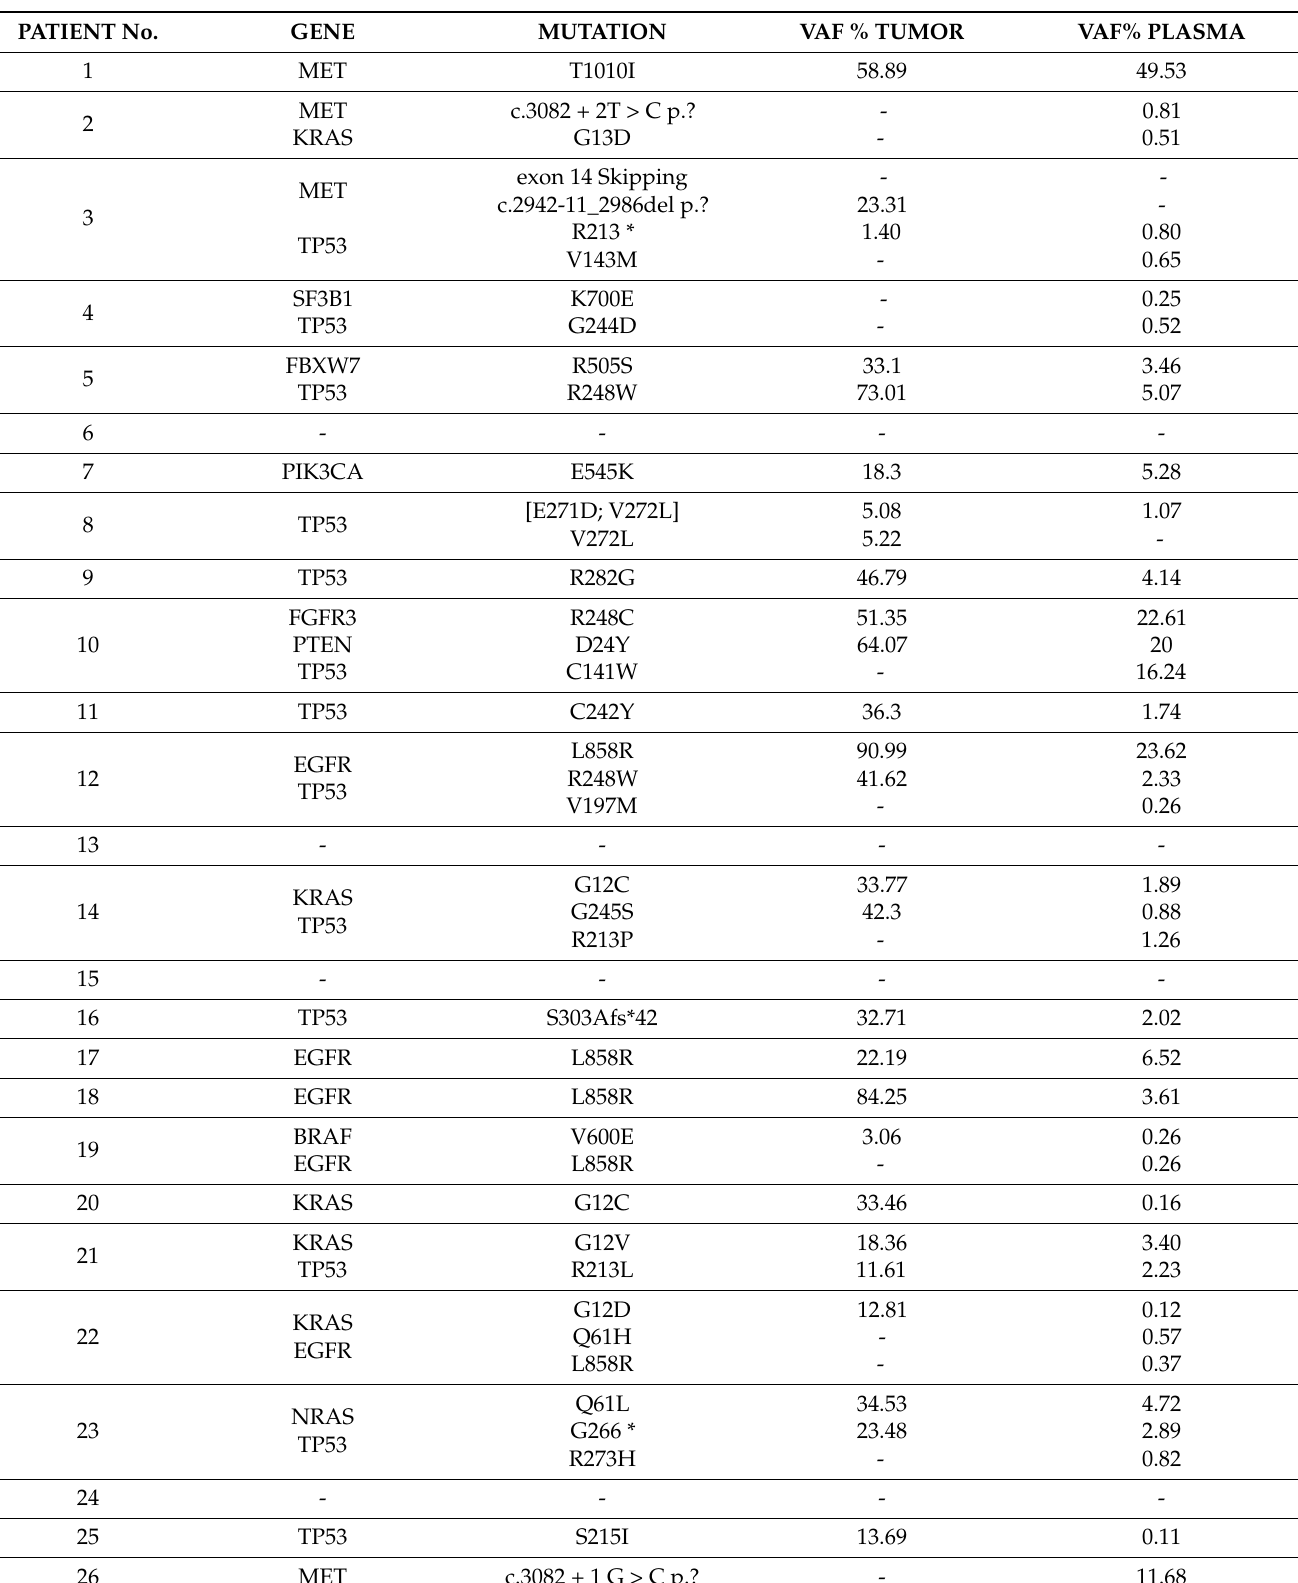
Table 3. Variants detected by NGS analysis in paired tumor and plasma